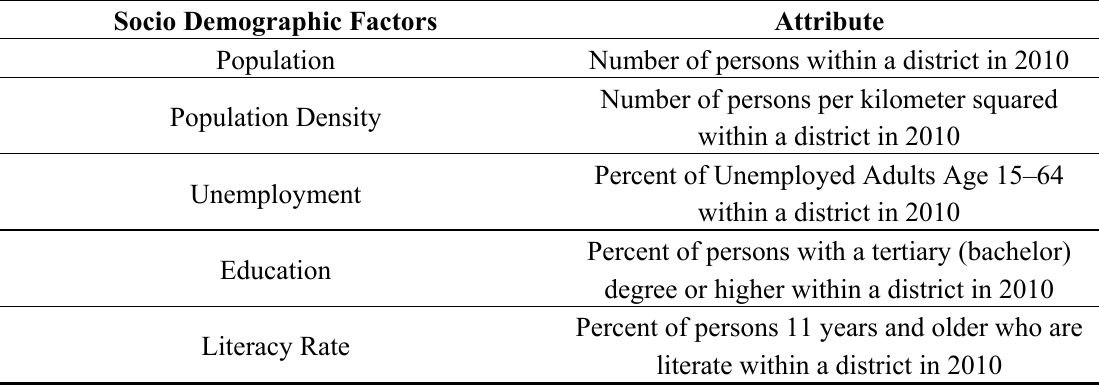
Table 3. Census variables used to evaluate demographic characteristics and their associations with contaminated sites.